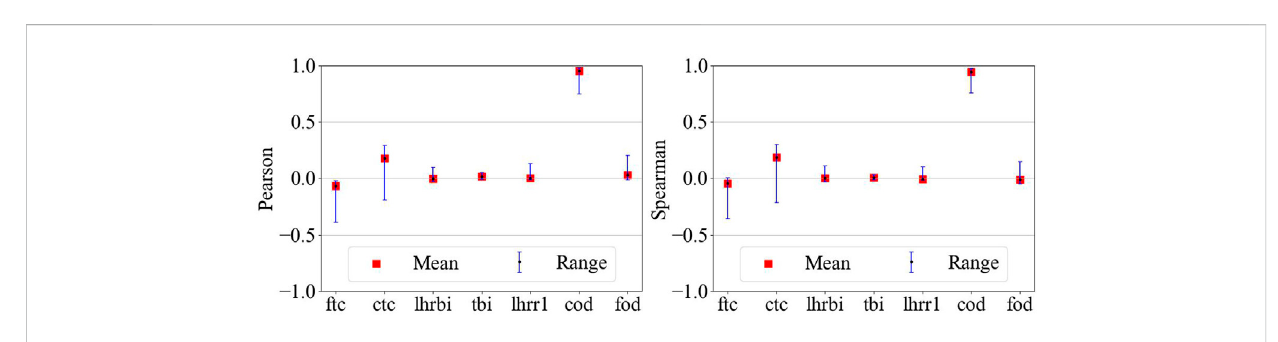
FIGURE 9 Pearson and Spearman for the average cladding outer